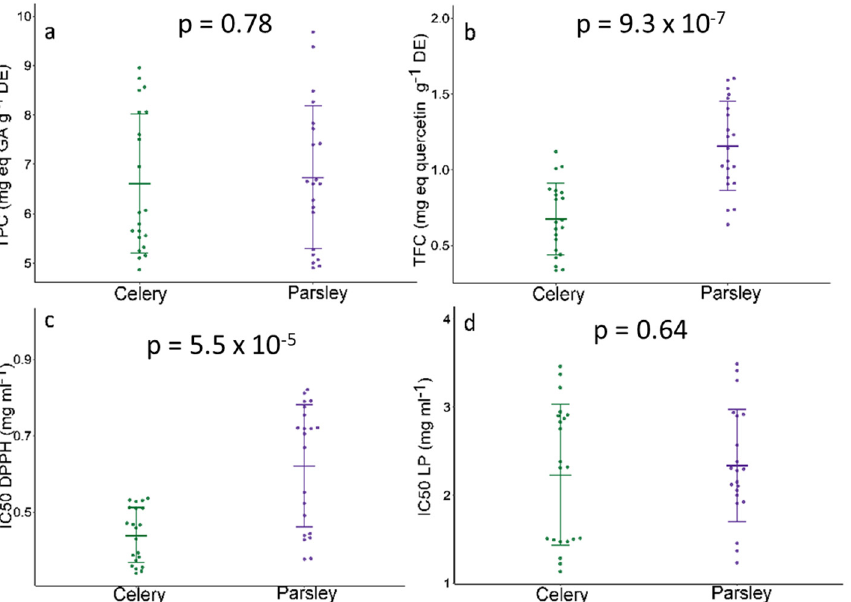
Figure 3. ( a ) TPC — total phenolic content; ( b ) TFC — total flavonoid content in celery and parsley Figure 3. ( a ) TPC—total phenolic content; ( b ) TFC—total flavonoid content in celery and parsley root; root; ( c ) IC50 DPPH — DPPH-radical scavenging capacity; ( d ) IC50 LP — inhibition of lipid peroxida- ( c ) IC50 DPPH—DPPH-radical scavenging capacity; ( d ) IC50 LP—inhibition of lipid peroxidation of celery and parsley extract. Data are presented as the mean ± standard deviation. An unpaired t